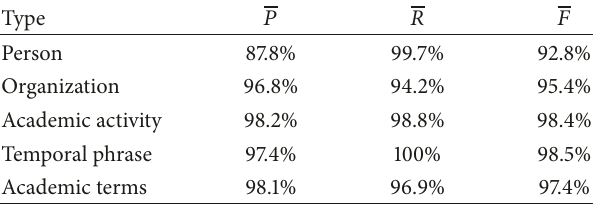
Table 3: Tenfold cross validation test results.